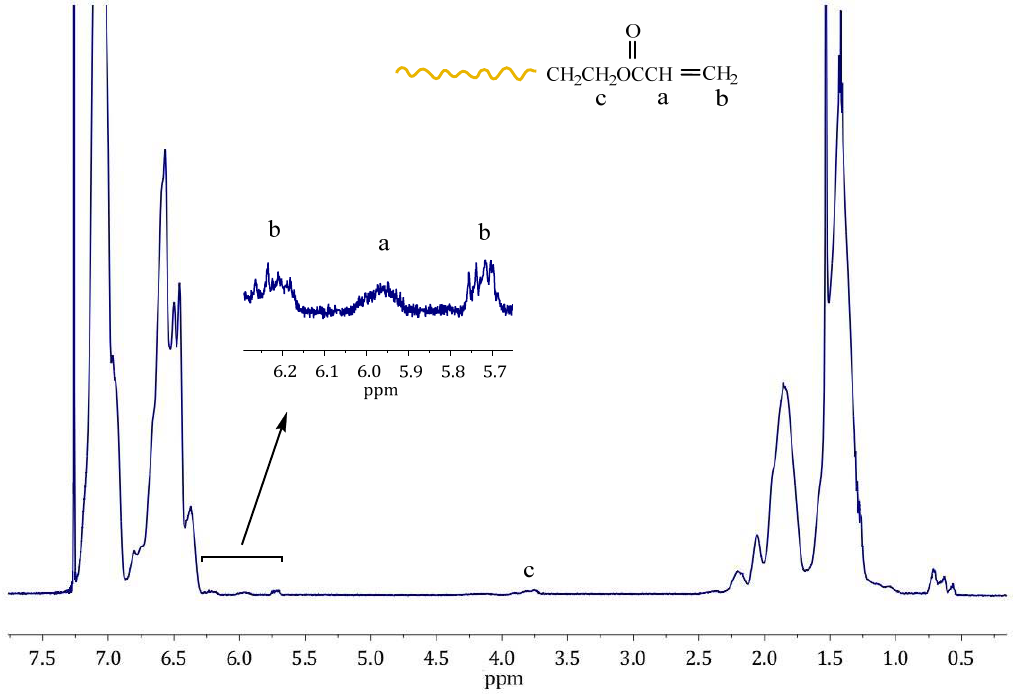
Figure 2. 1 H-NMR spectrum of sample PS-Acrylated. Figure 2. 1 H ‐ NMR spectrum of sample PS ‐ Acrylated.